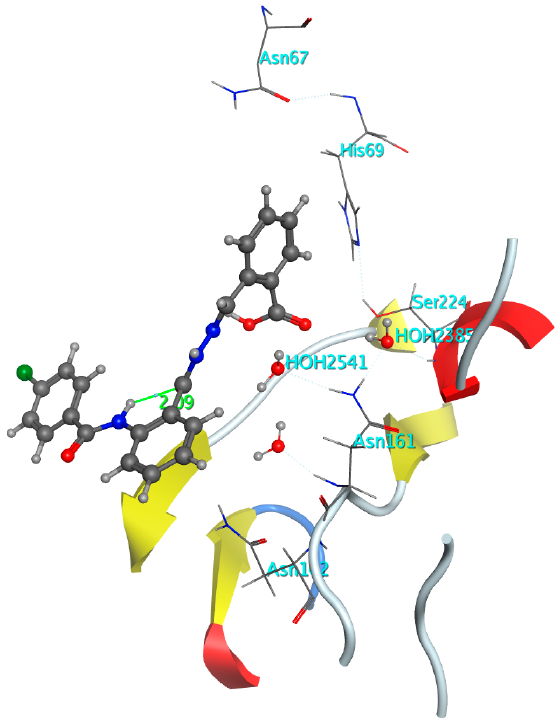
Figure 4. Docking pose for compound 6l as a representative, in the active site of proteinase